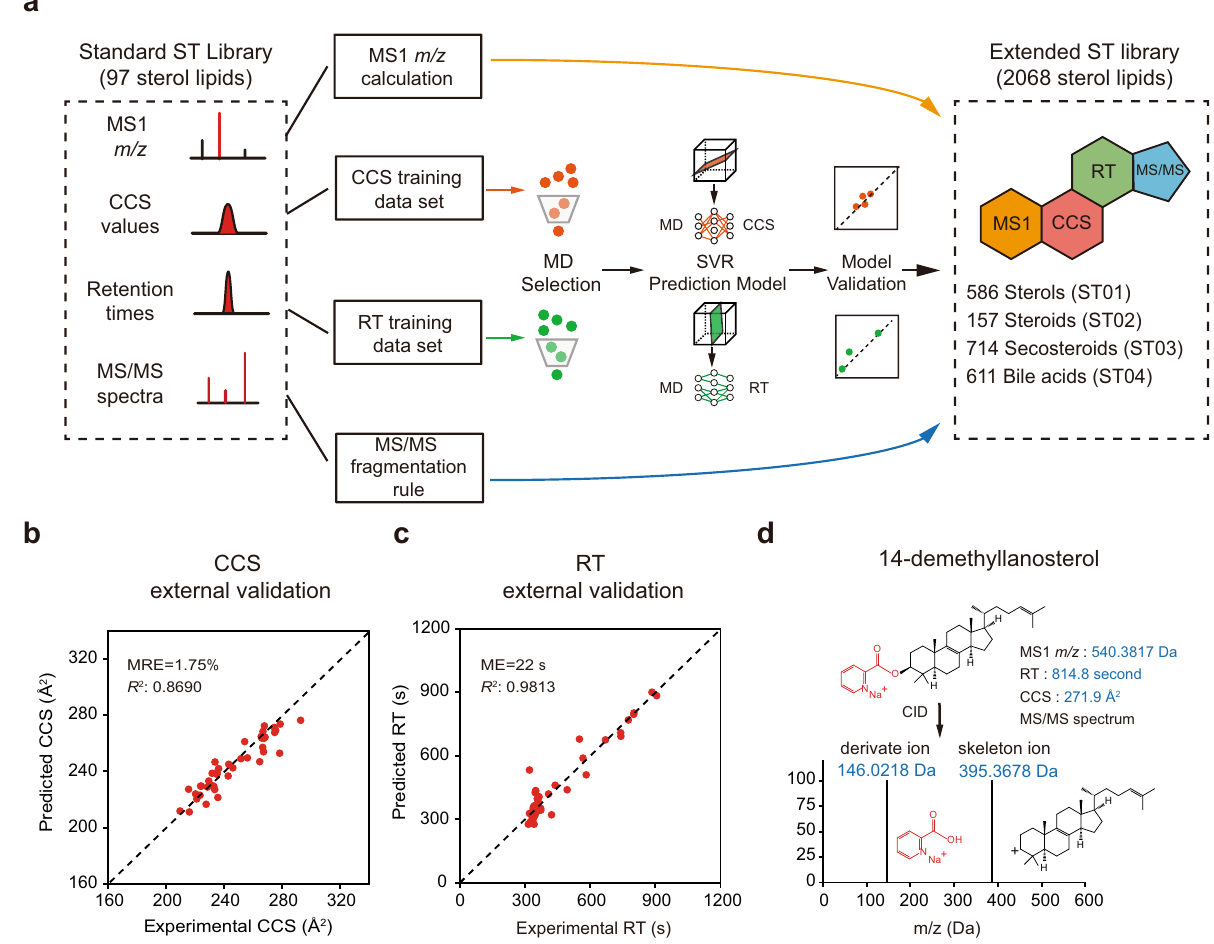
Fig. 3 Machine learning-enabled four-dimensional library for the analysis of sterol lipids. a Schematic illustration of the work fl ow to curate the standard and extended ST libraries with four-dimensional information. b The external validation of the machine-learning algorithm predicted CCS values of sterols ( n = 42). c The external validation of the machine-learning algorithm predicted retention times (RTs) of sterols ( n = 42). d An example of four-dimensional information of 14-demethyllanosterol in the extended ST